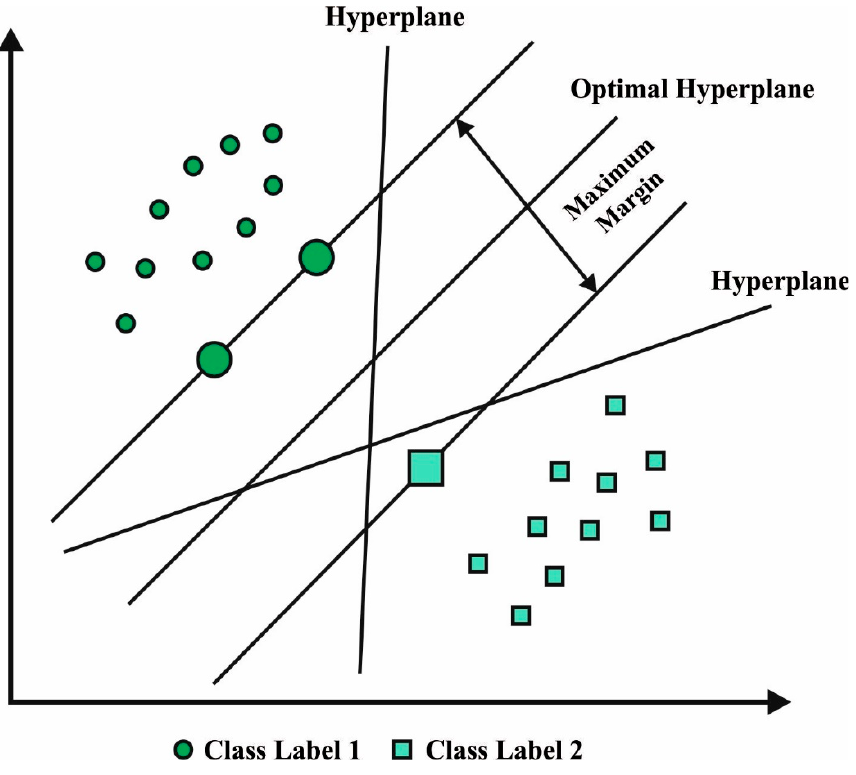
Figure 2. SVM hyperplane.